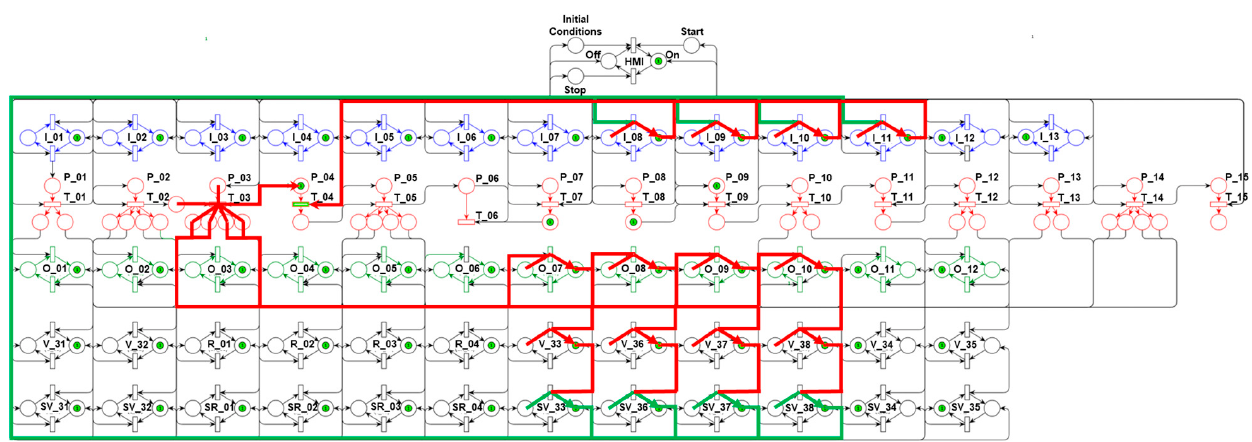
Figure 22. Algorithm’s eighth step—Open valves.